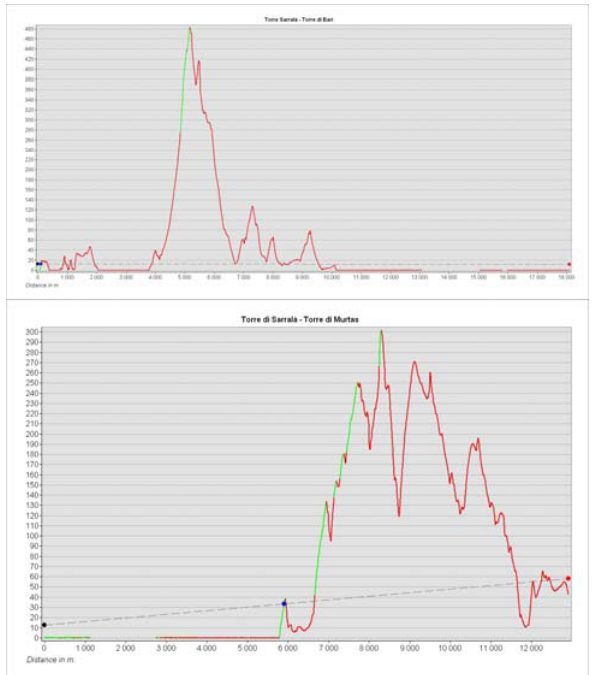
Figure 9 and 10: Altimetry profiles between the Sarralà Tower respectively the previous and next the tower.